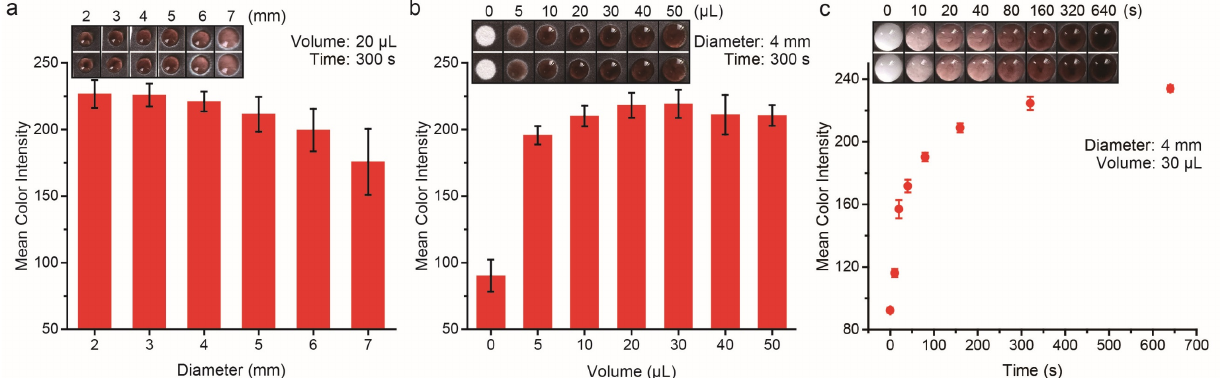
Figure 2. Measurement of mean color intensity with varying ( a ) the diameter of reaction zones, ( b ) the reaction buffer volume, and ( c ) the time course of HRP–DAB enzymatic reaction. The inset shows the corresponding images. The error bars represent standard deviations of four independent experiments.